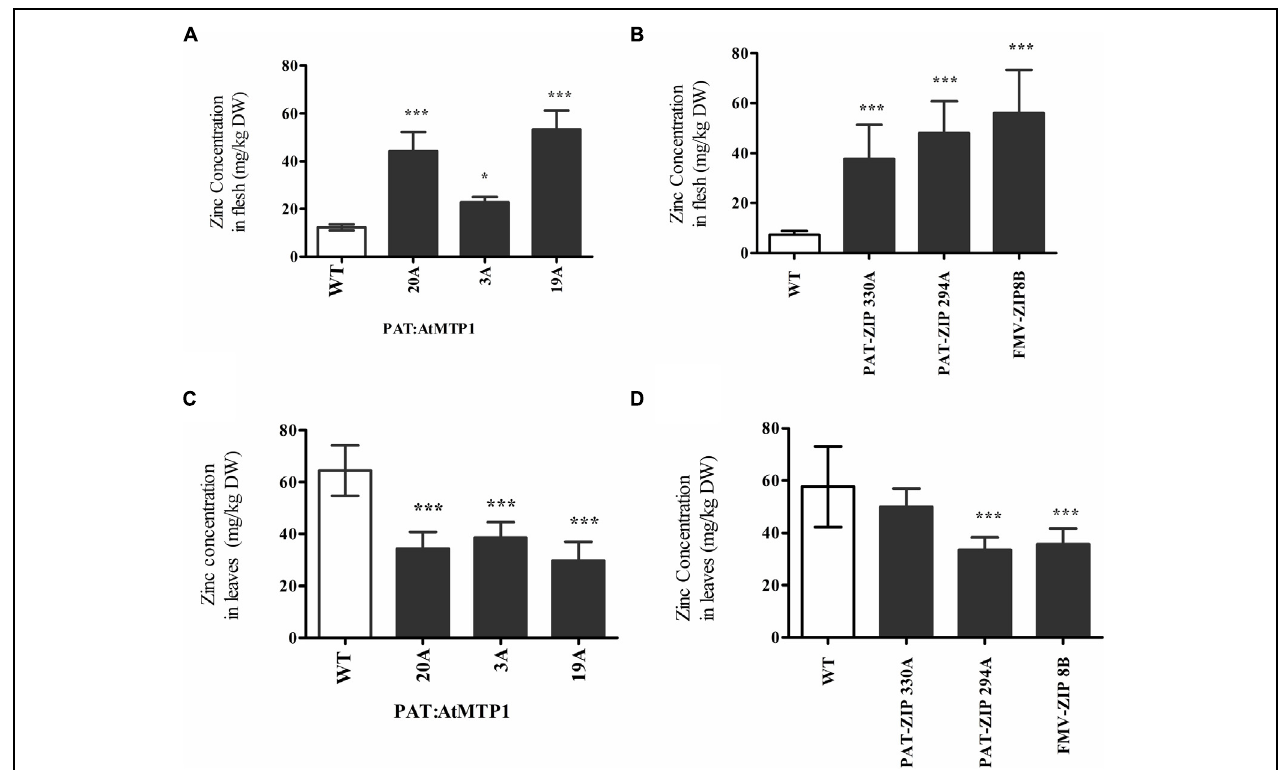
FIGURE 4 | Zinc concentration in the edible part of the storage roots (A,B) and leaves (C,D) of six independent transgenic PAT:At MTP1 , PAT:At ZIP1 , and FMV:At ZIP1 events after 6–8 months of growth in a greenhouse soil bed. Data represent the mean zinc